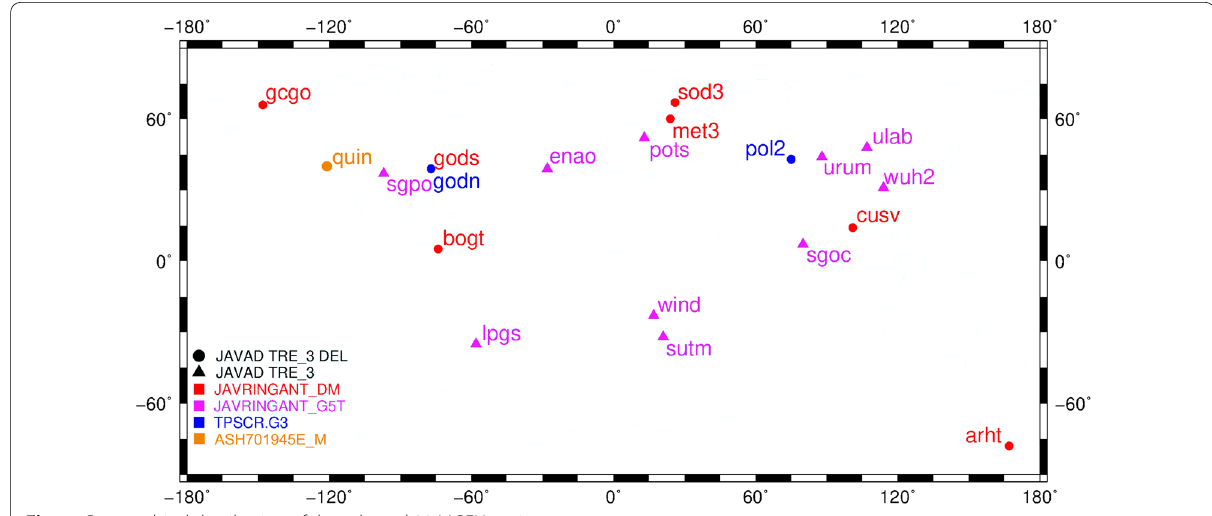
Fig. 1 Geographical distribution of the selected 20 MGEX stations